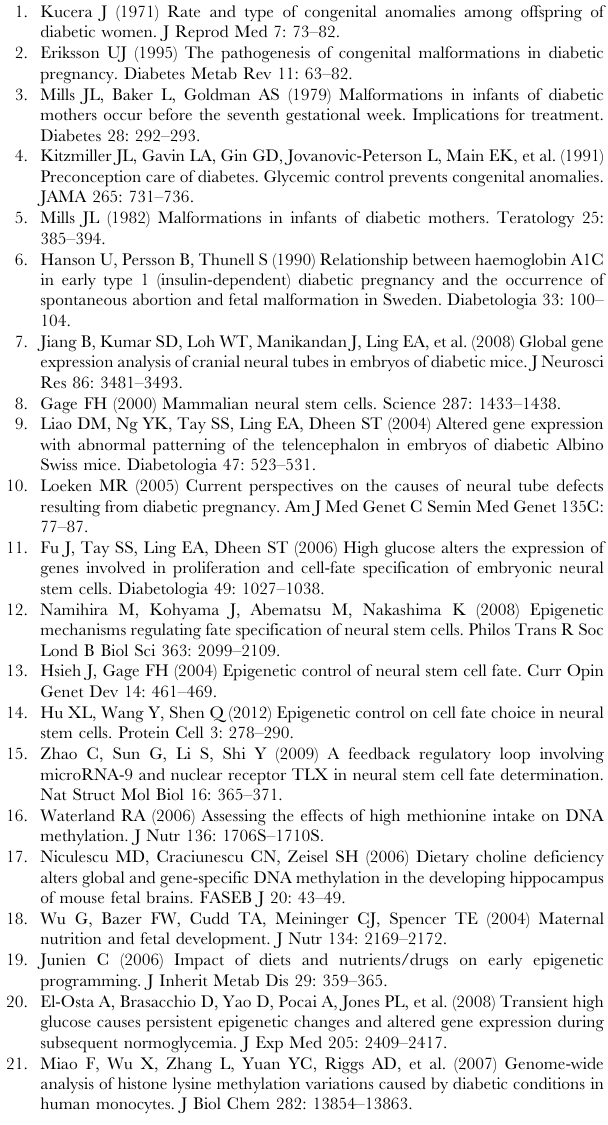
Figure S2 Bisulphite sequencing of DNA from NSCs from control, diabetic pregnancy and that exposed to HG in vitro was performed and methylation pattern was represented as lollipop grid. There was no change in CpG methylation status at Pafah1b1 promoter in NSCs from diabetic pregnancy or that exposed to HG in vitro when compared to the control. Data from six clones is represented here where each row represents the sequencing information received from a single clone across 27 CpG sites ( 2 310 to 2 46). Open circles represent unmethylated CpG sites and closed (shaded) circles represent methylated CpG sites. Figure S3 (A–H) Neurospheres from embryos of control and diabetic pregnancy were allowed to differentiate for six days in vitro and the expression of neuronal